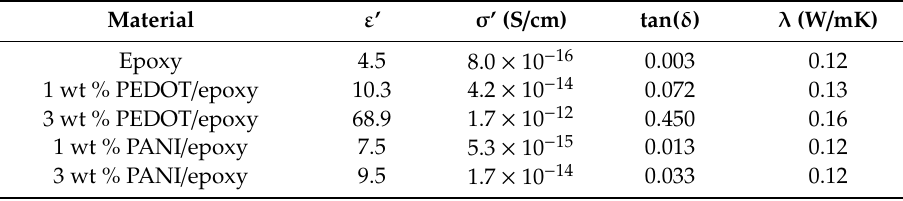
Table 2. Summary of the dielectric at 0.1 Hz and thermal conductivity properties of the CP / epoxy blends.